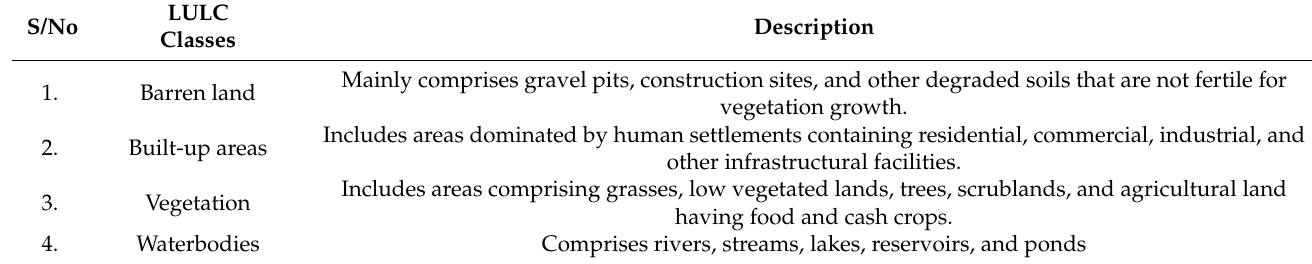
Table 3. Description of the study’s LULC